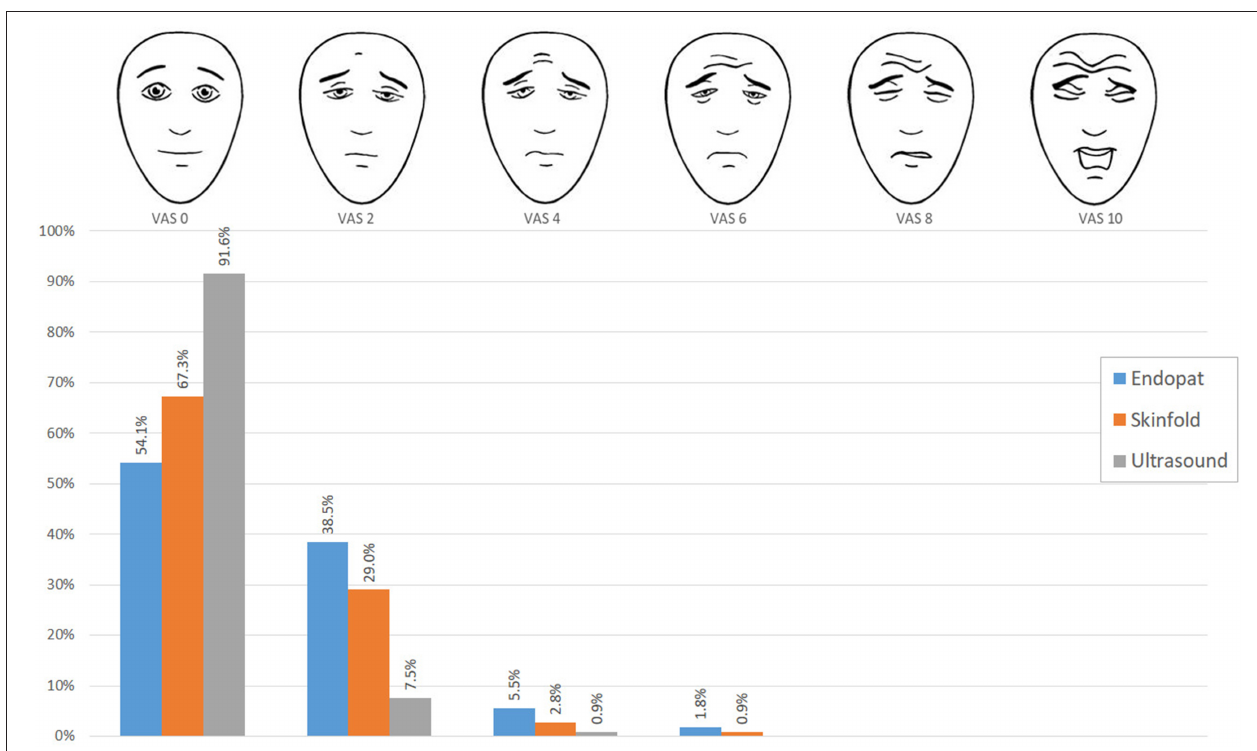
FIGURE 3 | Distribution of FPS-R scores. The blue bars indicate the FPS-R scores filled out after the PAT measurement, the orange bars indicate the FPS-R scores after skinfold measurement, and the gray bars show after the ultrasound